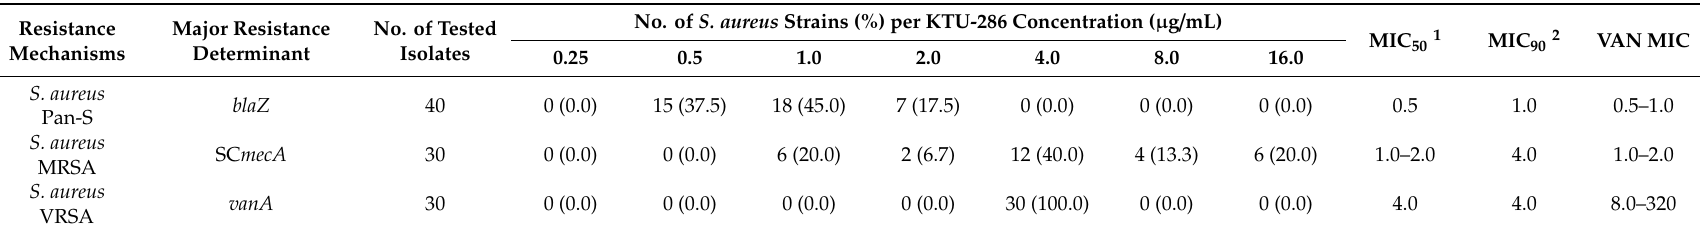
Table6. Thedistributionofminimalinhibitoryconcentration(MIC)valuesofKTU-286among Staphylococcusaureus ( n = 100)strainswithdefinedresistancedeterminants. Resistance